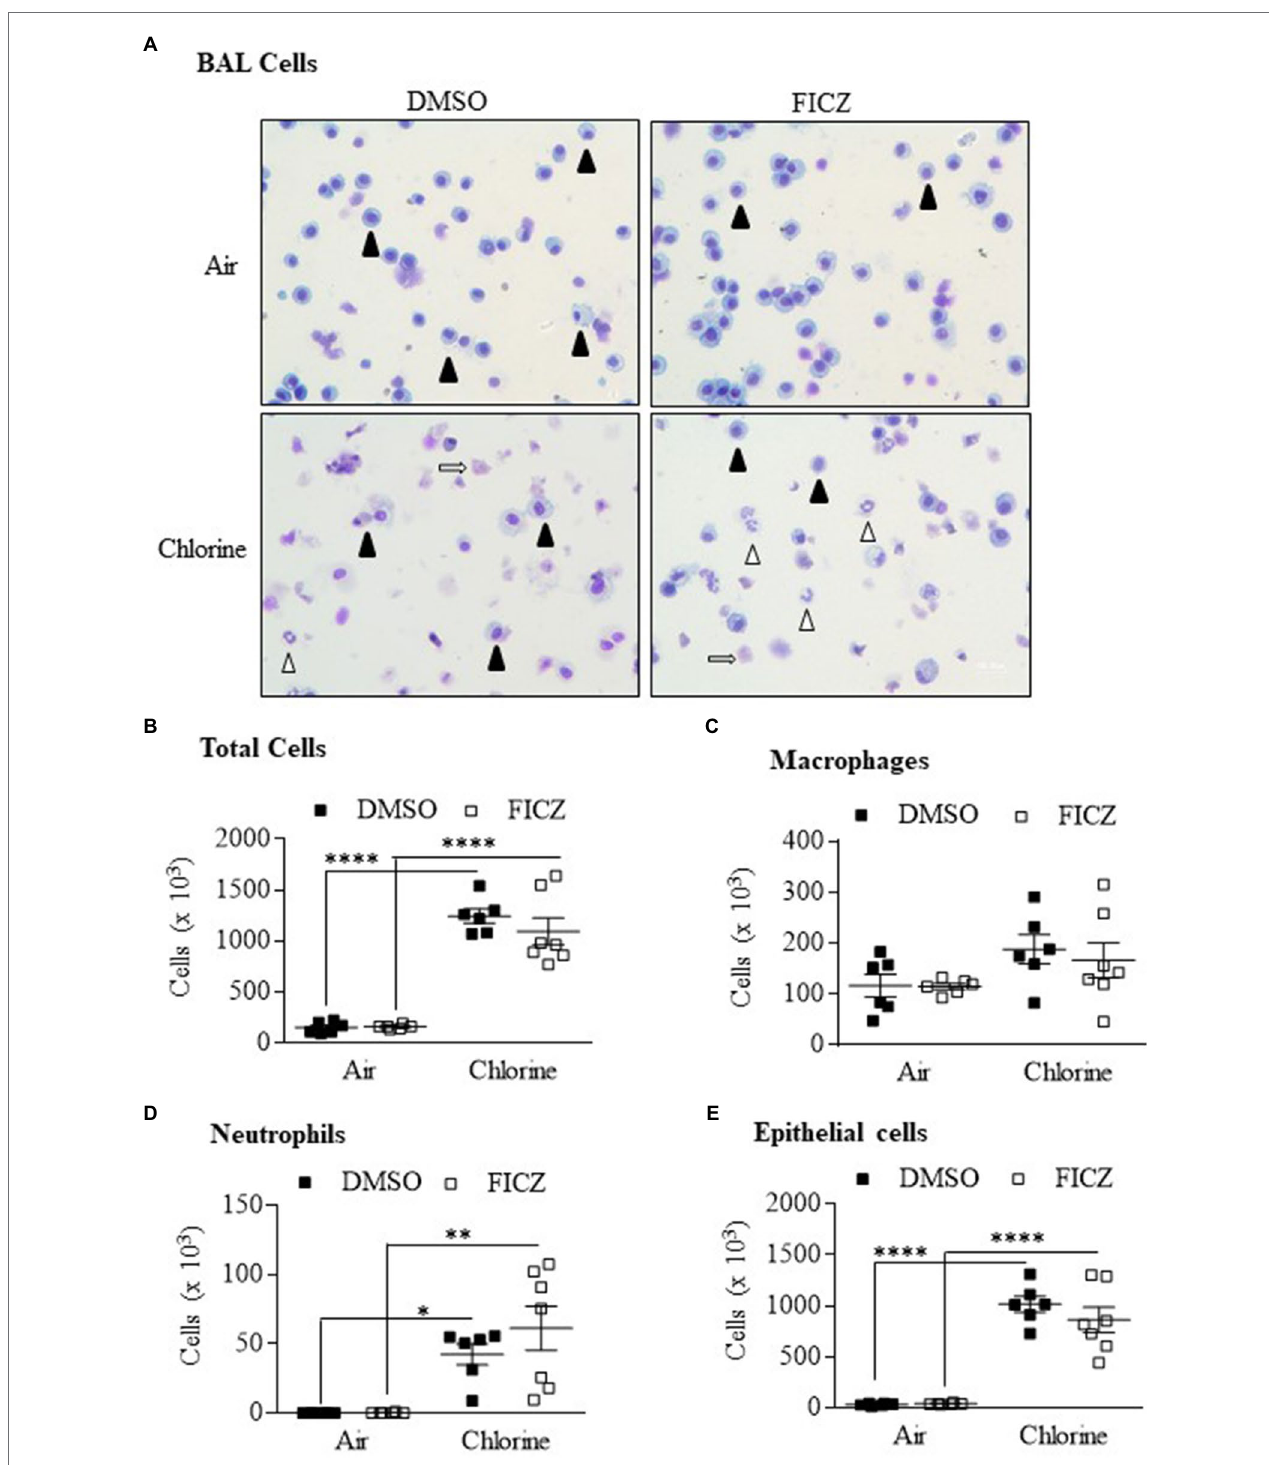
FIGURE 8 | 6-Formylindoleo [3,2-b] carbazole (FICZ) does not attenuate Cl 2 -induced airway inflammation. (A) BAL cells – there was an increase in neutrophils (open arrowheads) and epithelial cells (open arrows) 24 h after exposure to Cl 2 . Macrophages are indicated as closed arrowheads. (B) Total Cells – there was a significant increase in total cells in mice exposed to Cl 2 (**** p = 0.0001). FICZ had no effect on the total number of cells. (C) Macrophages – FICZ did not change macrophages in response to